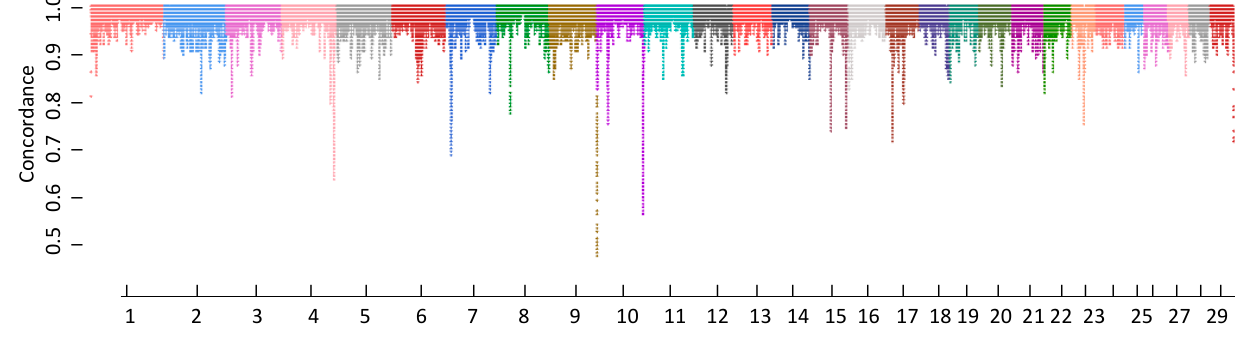
Figure 5. Smoothed concordance rate across 29 autosomes in Hanwoo cattle.